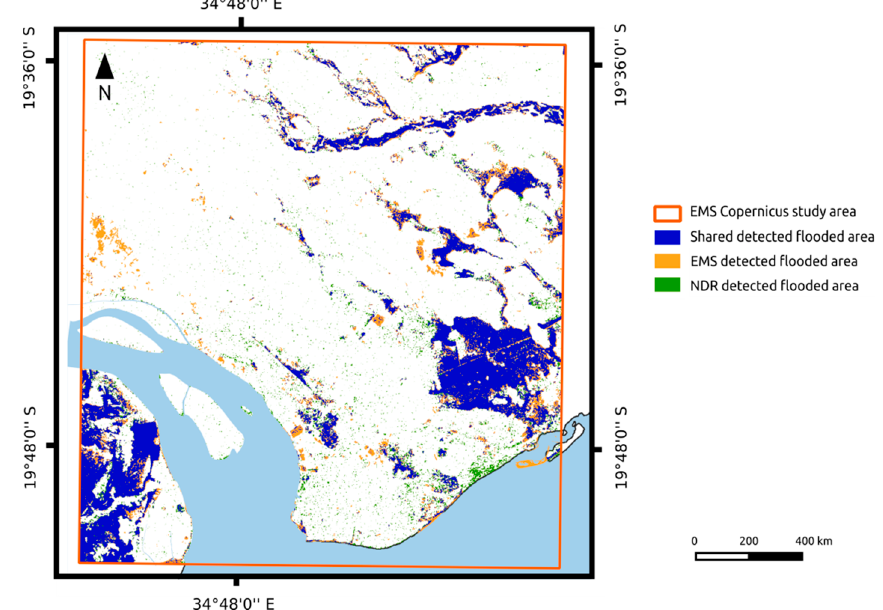
Figure 9. Flood detection comparison between NDR and EMS Copernicus in Beira area.